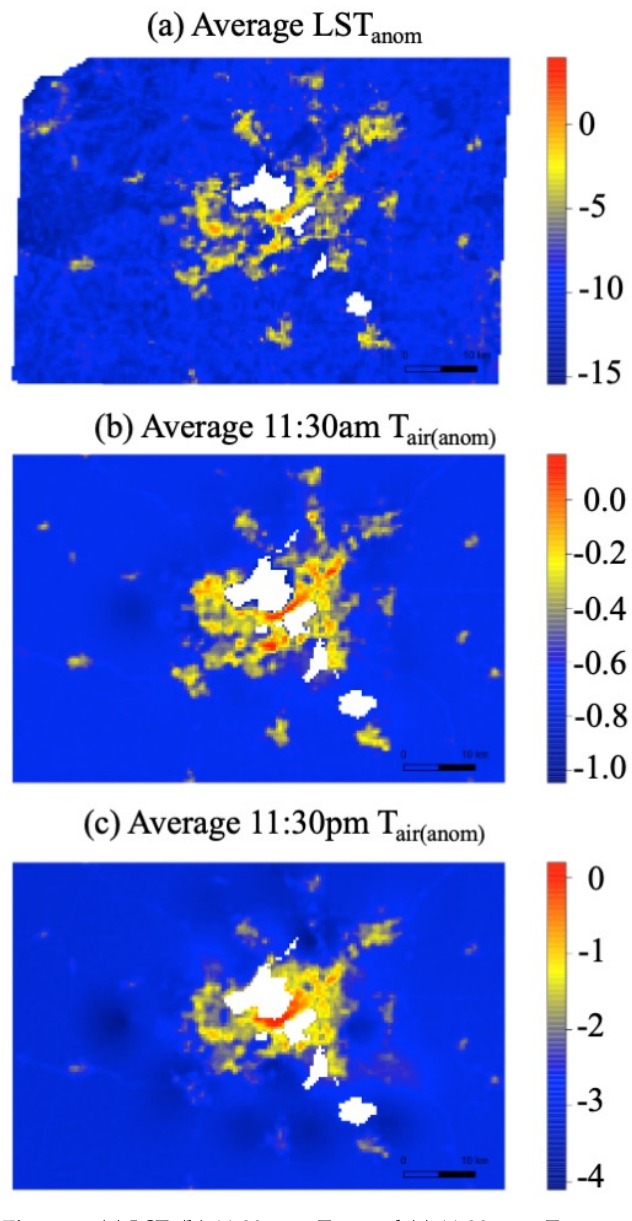
Figure 2. ( a ) LST, ( b ) 11:30 a.m. T air , and ( c ) 11:30 p.m. T air anomalies at 400-m resolution, averaged over the 15 dates studied. Temperatures of the lakes (in white) are masked out. The magnitude of difference between T air(anom) and LST anom varied by time of day and between rural and urban settings (Figure 3). Across all pixels, the difference between surface and air temperatures was greater during the day than at night ( p < 0.001). This smaller difference at night than during the day held true for both urban (Figure 3b) and rural (Figure 3c) settings ( p < 0.001 for both cases). In addition to this disparity between day and night, the difference between T air(anom) and LST anom was lower for urban pixels than rural ones, at both 11:30 a.m. ( p < 0.001) and 11:30 p.m. ( p <